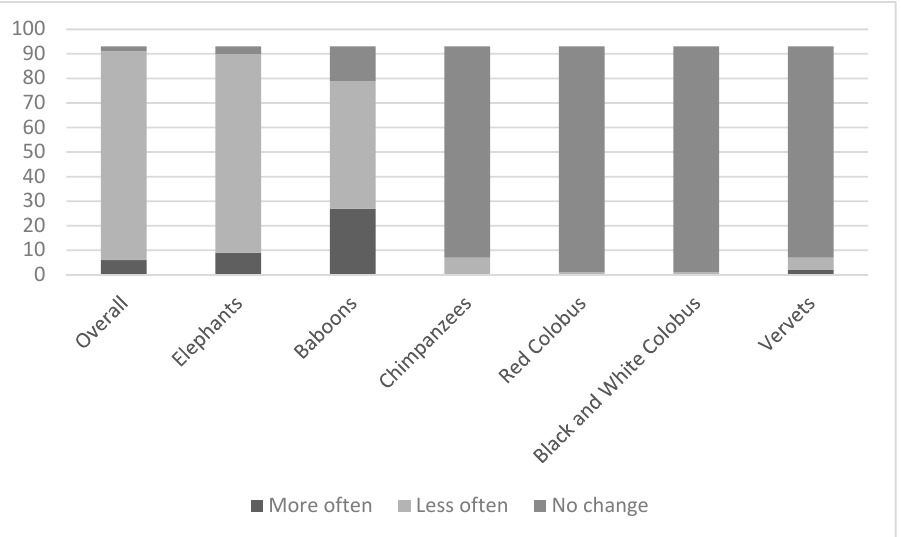
Figure 4. Reported changes in crop raiding patterns according to respondents from Community 4 ( n = 41).